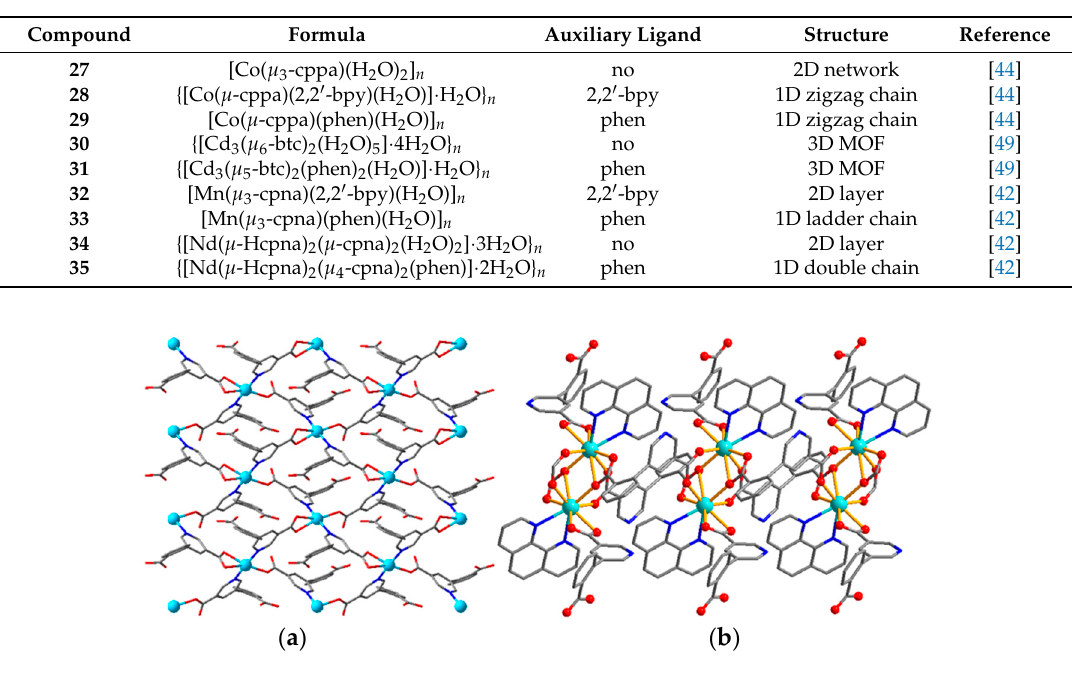
Table 6. Selected examples of CPs showing an effect of template on product structure. Compound Formula Template Structure